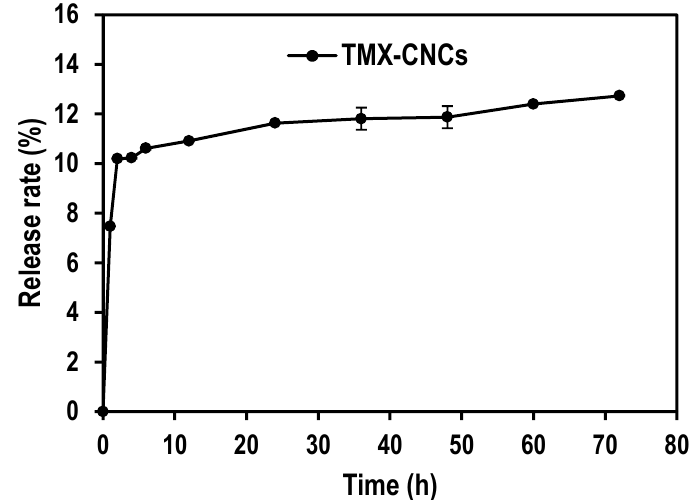
Figure 7. Release rate % of TMX from TMX-loaded CNCs in phosphate buffer solution (pH 7.4). Errors bars indicate standard deviation ( n = 3).